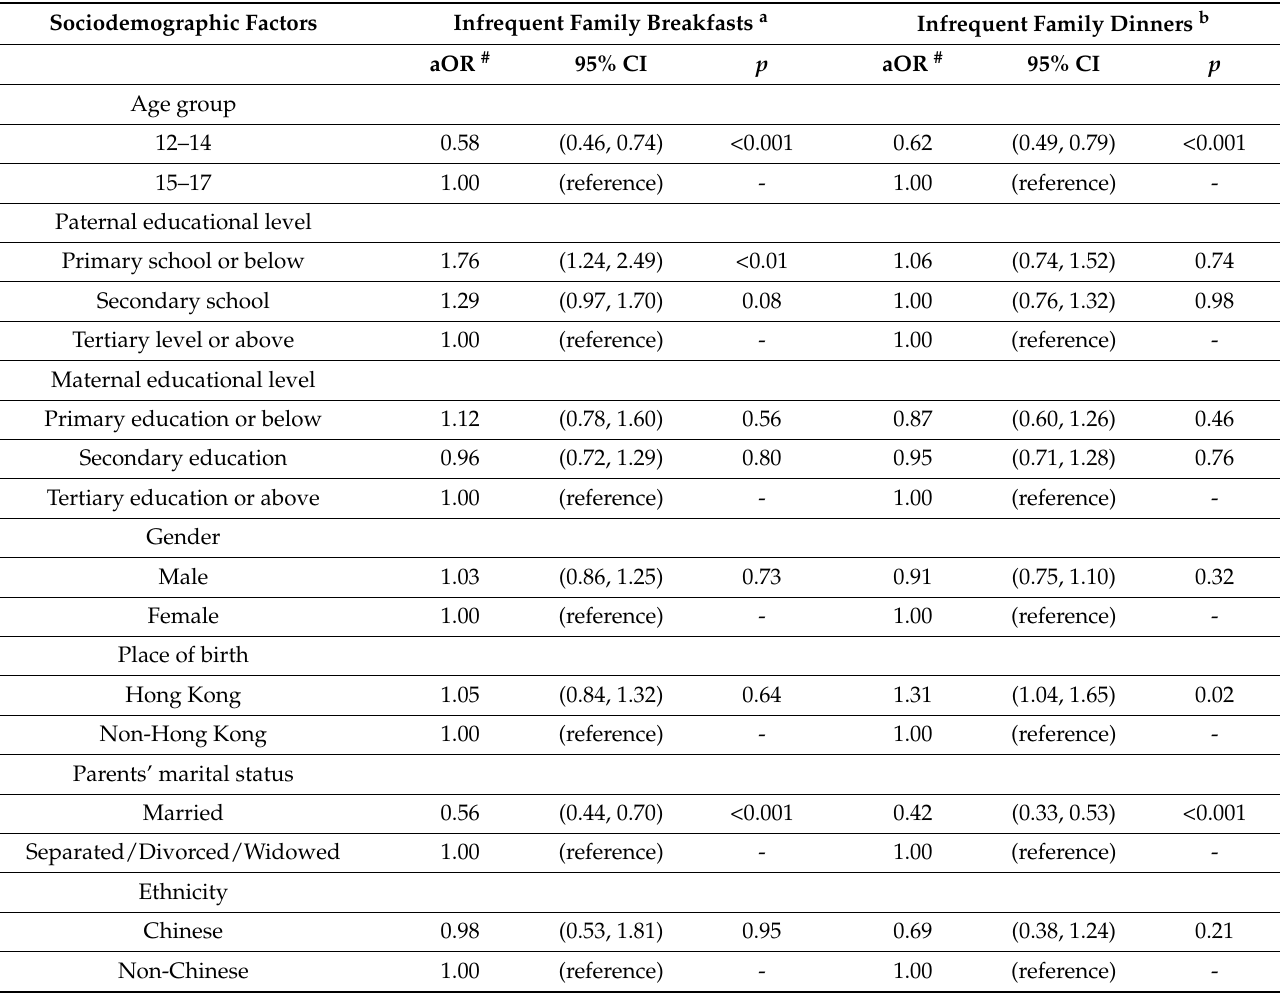
Table 2. Logistic regression analyses of the associations between sociodemographic factors and infrequent family breakfasts and